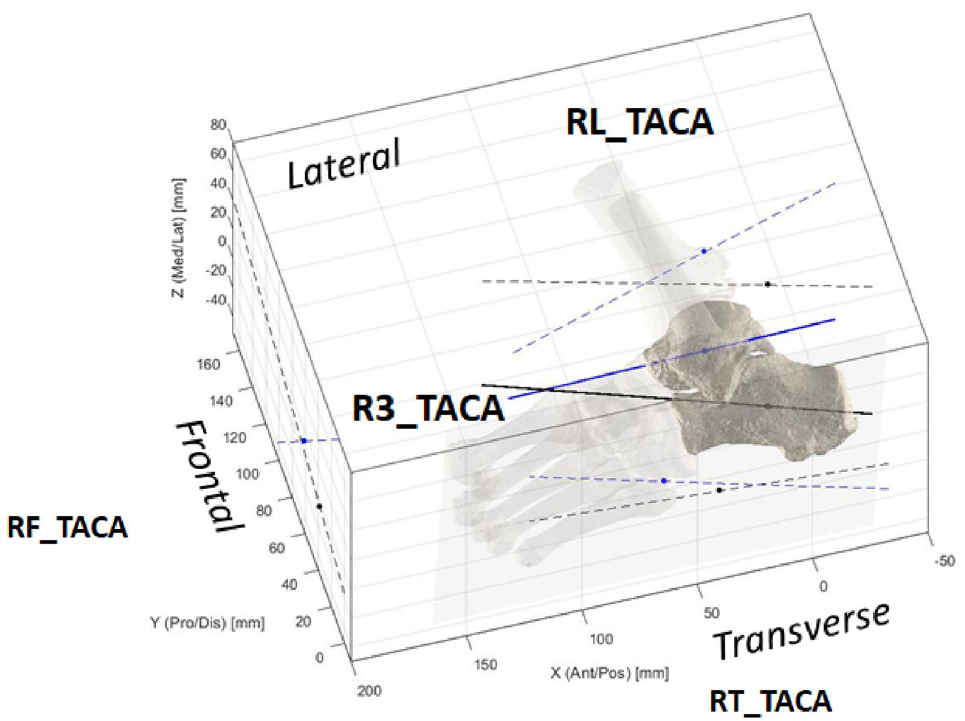
Figure 3. A diagram representing a typical fully 3D calculation of the angles between the longitudinal axes of the talus and calcaneus (‘TACA’): the three projections on the anatomical planes (RL_ RF_ RT_), and the single overall 3D calculation